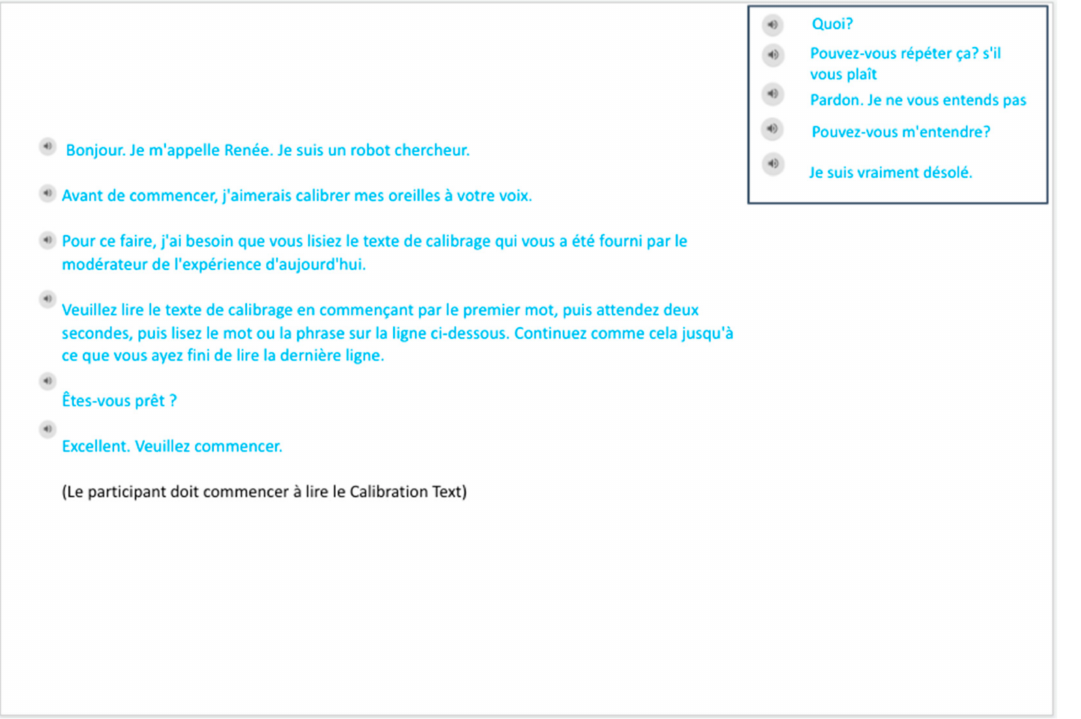
Figure 1. Google slides presentation featuring dialogue